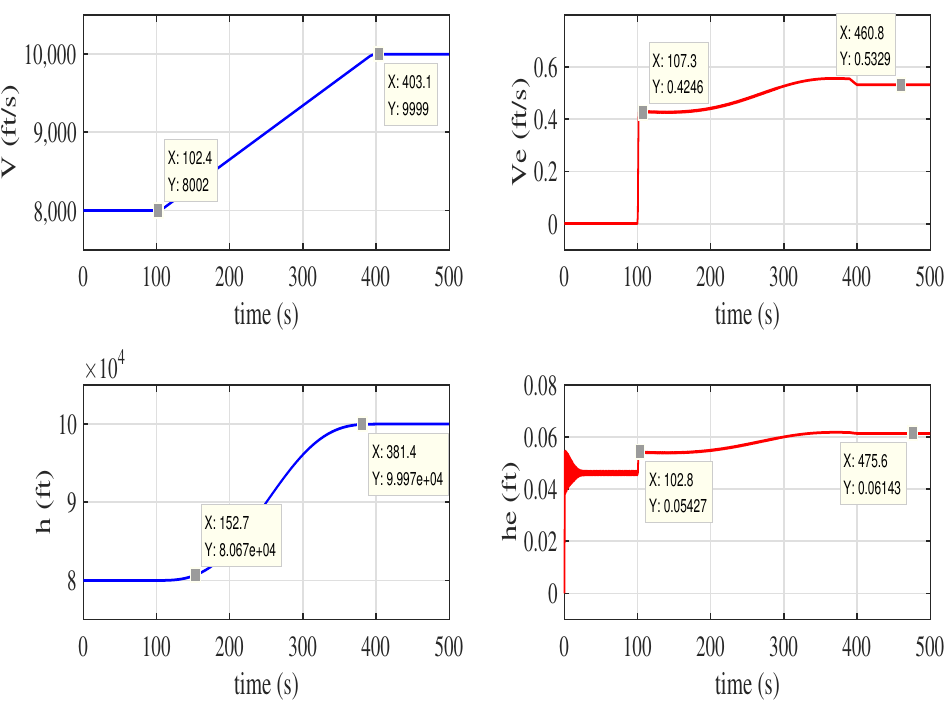
Figure 8. Velocity error and altitude error proposed by PID controller in pitching maneuver and fault free state.